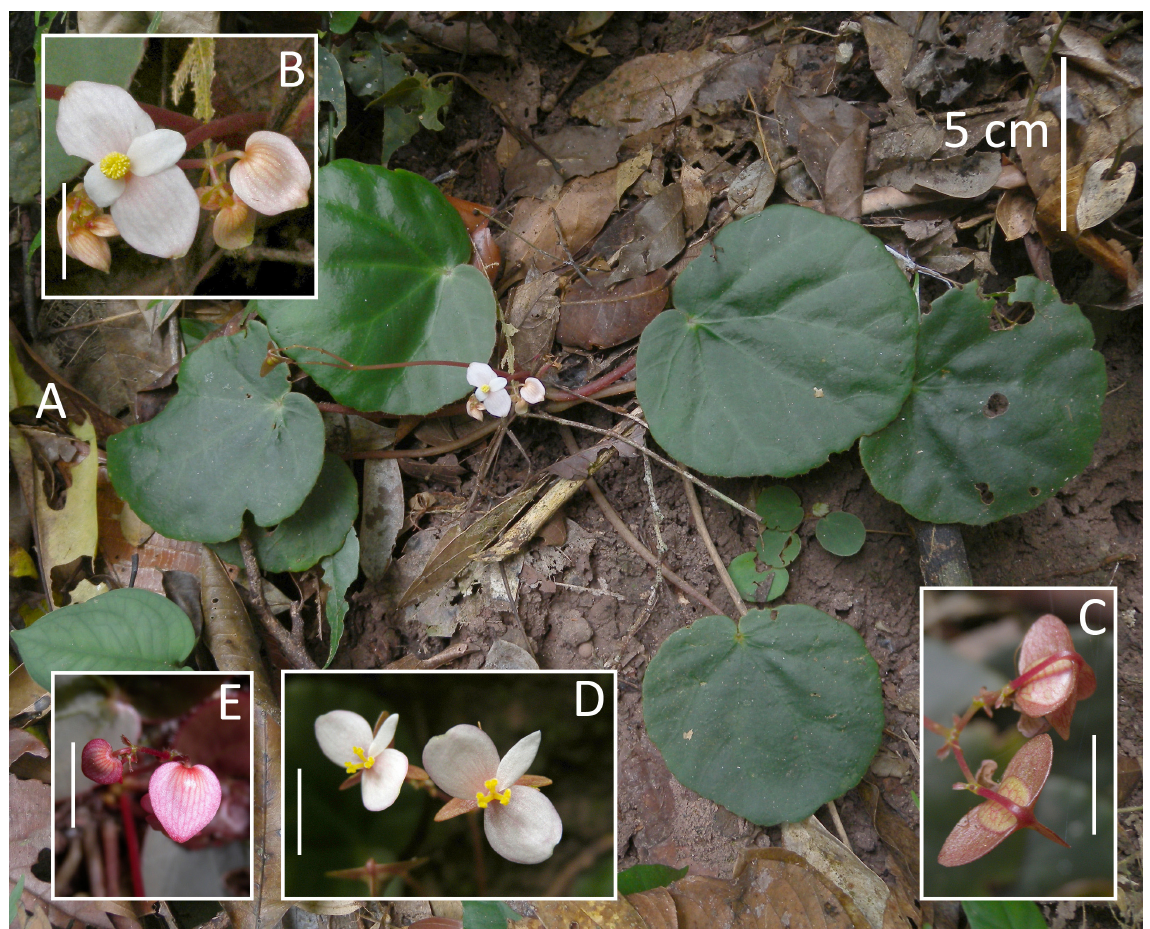
Fig. 17. Begonia simolapensis Ardi sp. nov. A . Habit. B . Male flower. C . Fruit on recurved pedicels. D . Female flowers. E . Male flower buds. All photographs from the type locality of Simolap. Scale bars on insets = 1